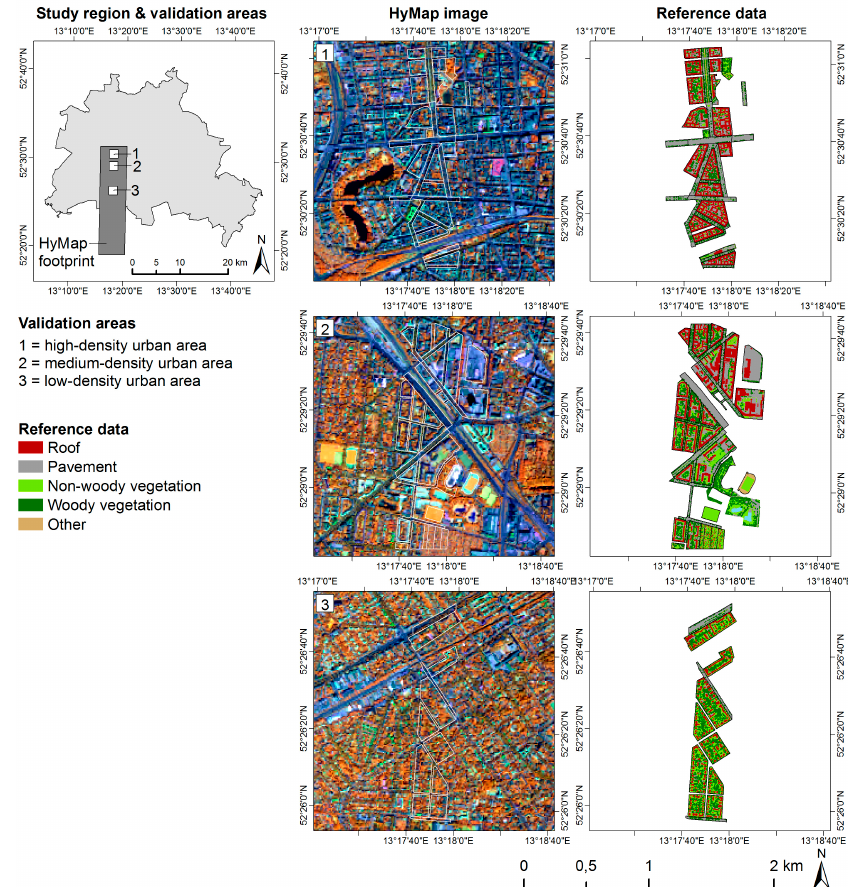
Figure 3. Berlin study area, along with the HyMap image (R = 833 nm, G = 1652 nm, B = 632 nm) and high resolution reference data for the three validation areas (polygons indicate the urban blocks used for